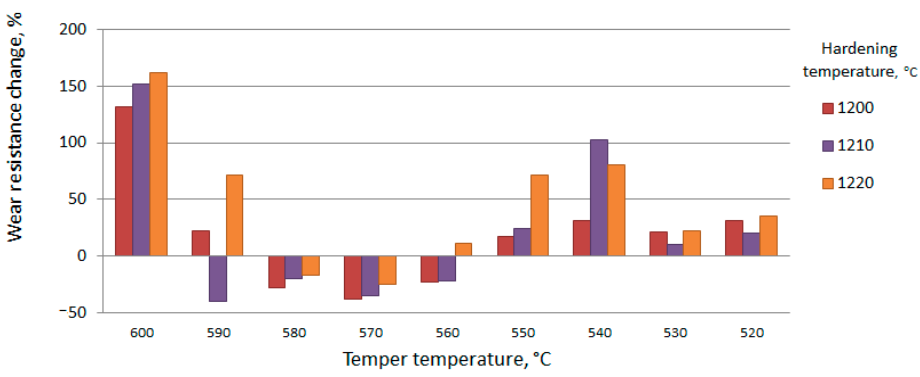
Figure 16. Effect of heat treatment modes on the change in relative wear resistance (%) (W6Mo5Cr4V2 ← TiCN + Ni).